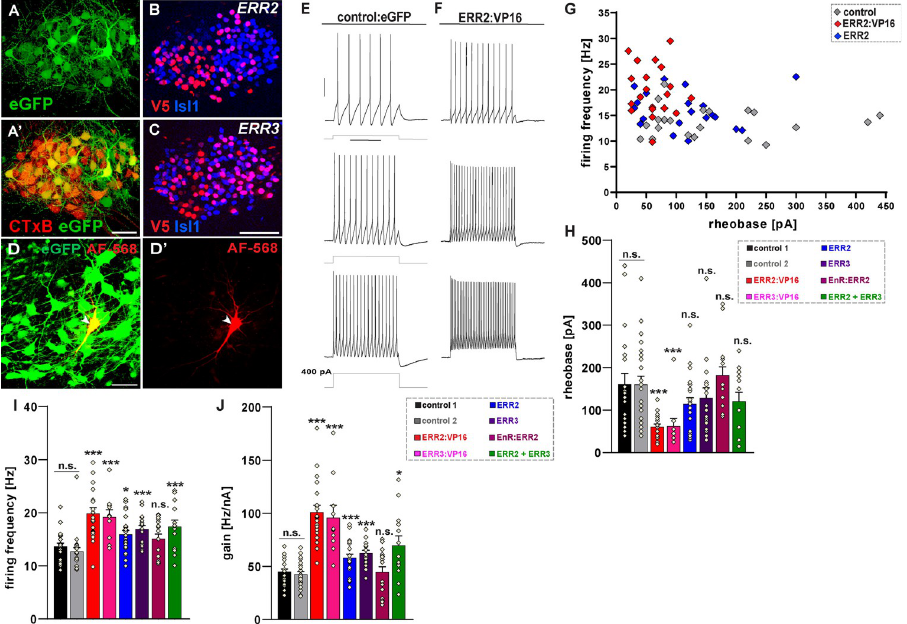
Fig 6. ERR2/3 promote a gamma motor neuron-like biophysical signature in chick through transcriptional activation. (A-D’) Overview of E12 chick spinal cord: stable transfection with expression vector driving eGFP expression (A) in ventral horn motor neurons. Higher magnification of eGFP expressing neurons further identified as motor neurons by retrograde cholera toxin B (CTxB) tracing upon in ovo injection into the hind limb (A’) (scale bar: 100 μ m). Examples of expression and nuclear localization of mouse ERR2 (B) and ERR3 (C) in chick motor neurons (detected via N-terminal V5 epitope tags) (scale bar: 30 μ m). eGFP + motor neuron recorded with patch pipette containing Alexa Fluor 568 dye (red) (D and D’) (scale bar: 50 μ m). (E, F) Example traces of current clamp recordings of chick motor neurons (in acute spinal cord slice preparations) forcedly expressing eGFP only (control) (E) or ERR2: VP16 and eGFP (F) , upon 100, 200, and 400 pA, 1 s square current pulses: motor neurons expressing elevated ERR2 levels exhibit higher firing rates and gear up their firing rates more rapidly in response to current pulses (F) . (G) Forced ERR2 and ERR2:VP16 expression ( n = 21, n = 20, respectively) shifts chick motor neuron properties towards a gamma motor neuron-like biophysical signature (high firing rates, low rheobases) compared to control (white, n = 23). (H) Decrease in rheobase upon ERR2, ERR3 ( n = 21) transfection, yet not significant, but significant decrease in rheobase upon ERR2:VP16 ( n = 20) or ERR3:VP16 ( n = 10). No decrease in rheobase upon ERR2:EnR ( n = 17) transfection. (I) Significant increases in gain upon transfection of ERR2, ERR3, ERR2:VP16 or ERR3:VP16, but not upon ERR2:EnR transfection. (H, I) Similar decreases in rheobase (H) , increase in gain (I) upon ERR2+ERR3 ( n = 13) cotransfection, compared to ERR2 or ERR3 single transfection. No differences detected between control 1 and control 2 with parameters recorded during two different experiments at different time points upon expressing “eGFP only” control vectors, thus demonstrating robustness of the assay. Data are presented as mean ± SEM. n = # of neurons. Statistically significant differences are indicated as: � p < 0.05, �� p < 0.01, ��� p < 0.001, n.s. = not significant, Student t test). Data for Fig 6G-J can be found in S4